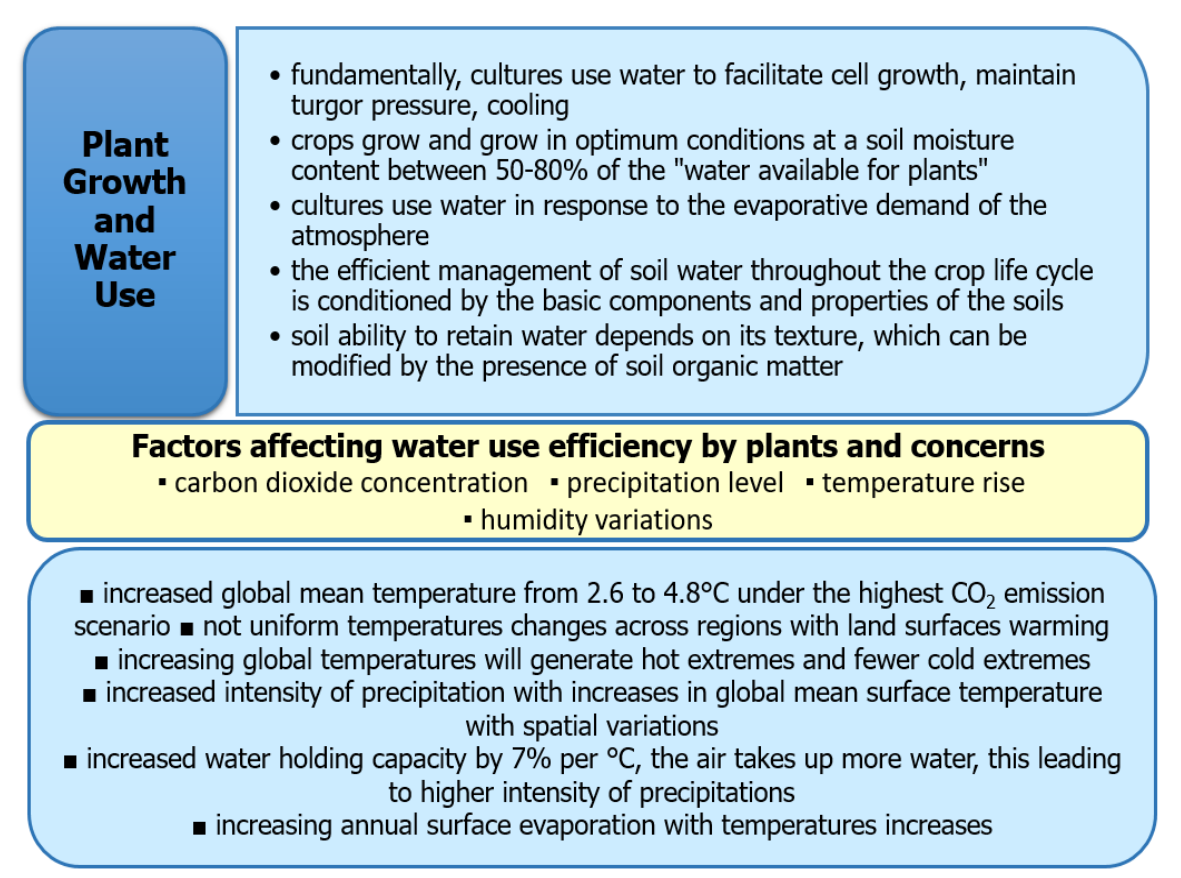
Figure 8. Factors changing in the climate that affects water use by plants.